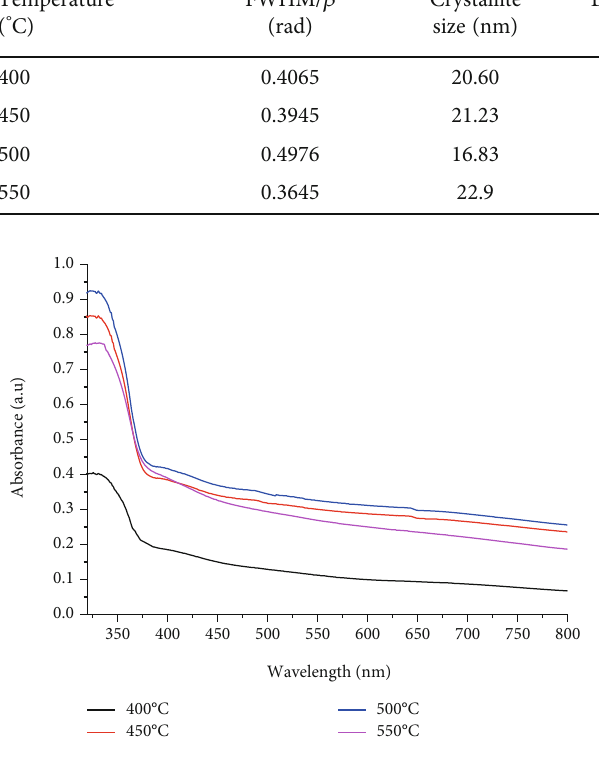
Figure 7: Tauc plot of Mg-doped ZnO thin fi lms at di ff erent annealing temperatures. Table 2: Bandgap energy of Mg-doped ZnO thin fi lm at di ff erent annealing